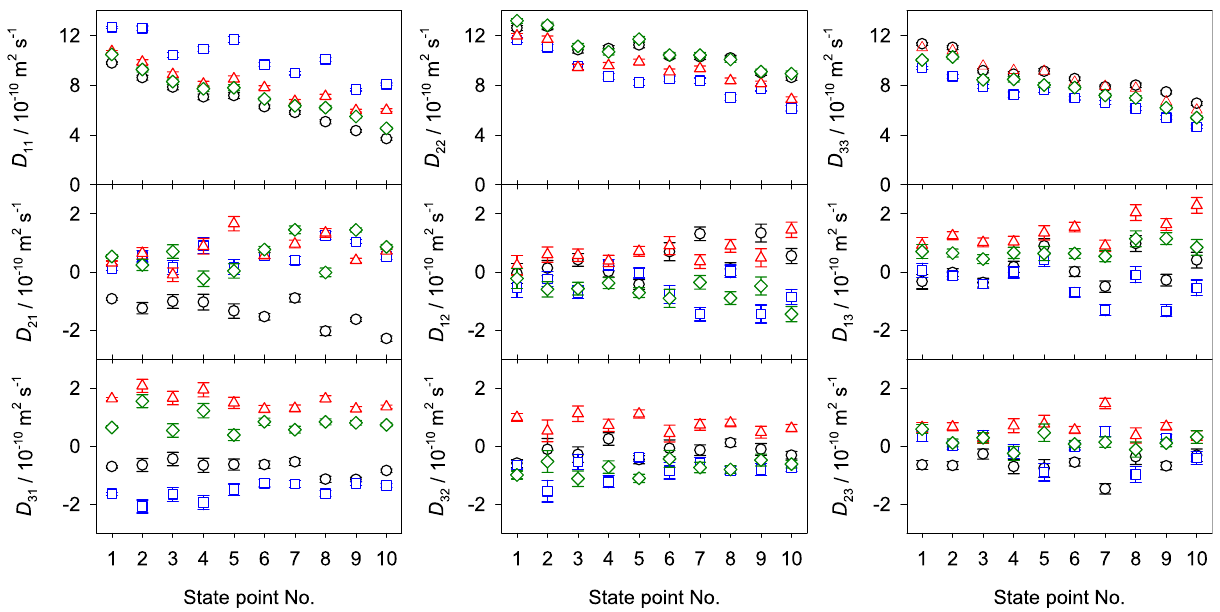
Figure 9. Elements of the Fick diffusion coefficient matrix in the molar velocity reference frame of the quaternary mixture water (W) + methanol (M) + ethanol (E) + 2-propanol (P) with varying component order: MEPW (blue squares), WEPM (red triangles), WMPE (green diamonds) and WMEP (black circles) at 298.15 K and 0.1 MPa. The last component is regarded as the solvent. Note that the indices i and j of D ij refer to the elements of the diffusion matrix for the corresponding component order. The molar composition of these state points is given in the supplementary Table S4